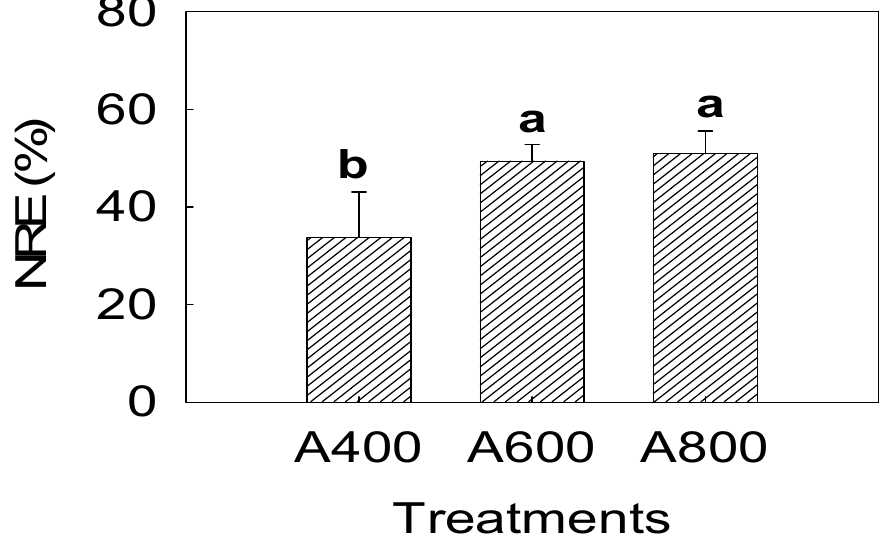
Figure 4. Effects of elevated CO 2 (A400—400, A600—600, and A800—800 µL L − 1 ) on leaf mass-based N contents ( a ) leaf mass-based C contents ( b ) and C / N ratio ( c ) in senescent leaves of red maple ( Acer rubrum L.). The values shown are mean ± SD. Different lowercase letters above bars mean significant multiple comparison results among CO 2 treatments when p < 0.05, n = 3.